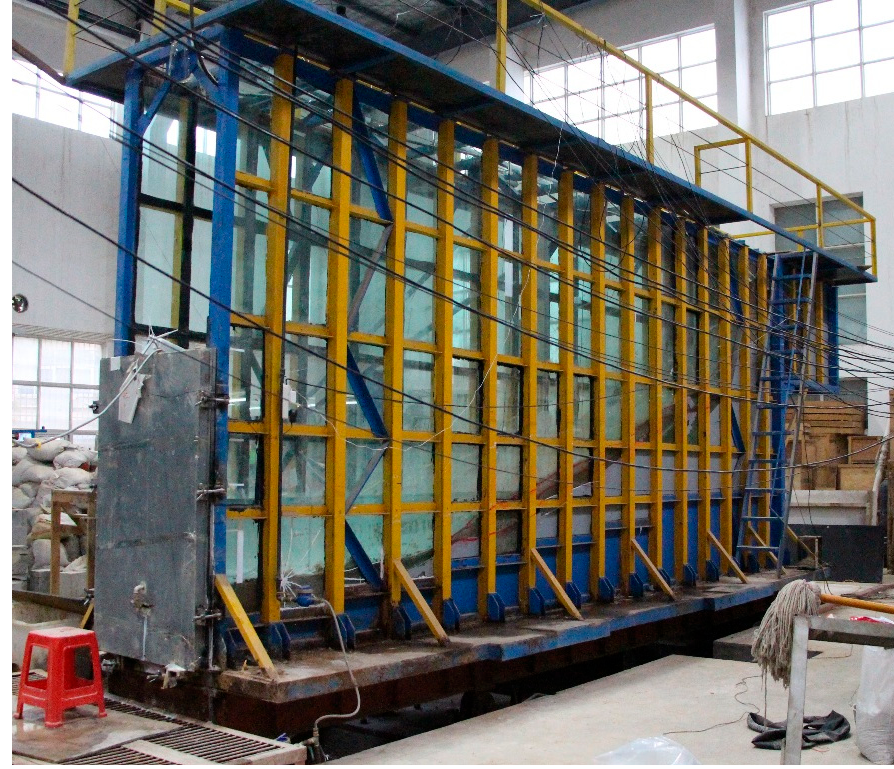
Figure 4. Landslide model test system.